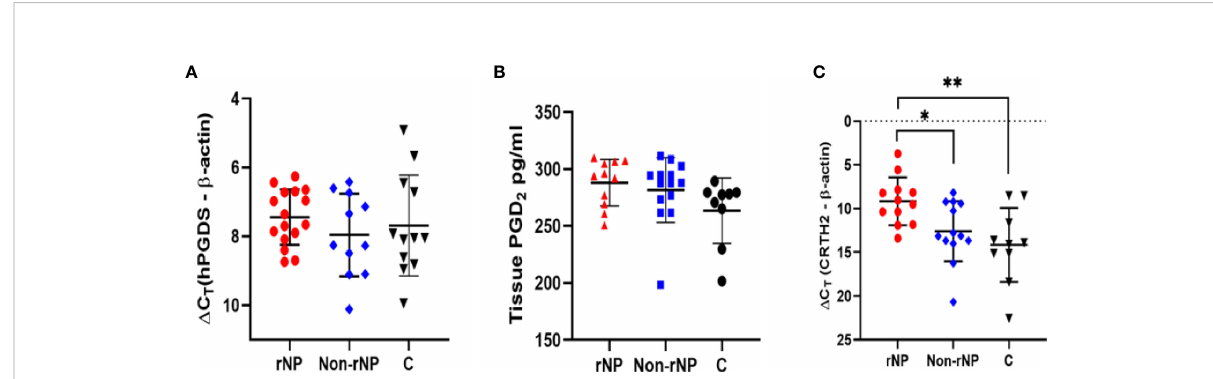
FIGURE 1 Screening of hPGDS-PGD 2 -CRTH2 pathway in nasal polyps. Nasal polyp tissues from rNP and Non-rNP groups and middle turbinate mucosa of the control group were collected and detected by real-time quantitative PCR and ELISA. No signi fi cant difference was observed among the groups in tissue hPGDS mRNA level (rNP group: n = 16; Non-rNP group: n = 11; control group: n = 12) (A) . The PGD2 levels of tissue homogenates measured by ELISA did not show any signi fi cant difference among these groups either (rNP group: n = 11; Non-rNP group: n = 14; control group: n = 9) (B) . CRTH2 mRNA level in rNP was signi fi cantly higher compared with Non-rNP and control groups (rNP group: n = 12; Non-rNP group: n = 13; control group: n = 10) (C) . D Ct (the Ct value of the target gene minus the Ct value of housekeeping gene b -actin) was used to compare the data among the groups. D Ct value was inversely proportional to the relative level of cDNA contained in the sample. C, control group. * P < 0.05, ** P < 0.01.